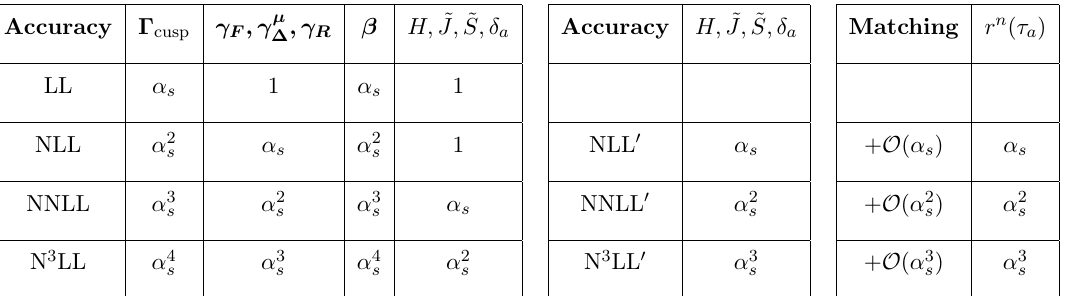
( (cid:11) n ). The tables apply to the s O